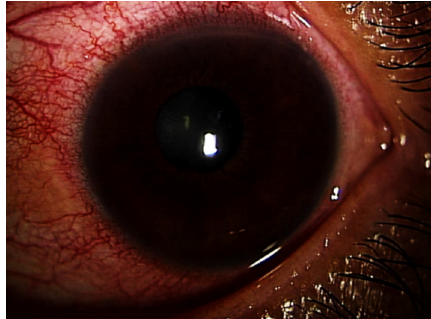
Figure 1: The chemosis with serous discharge